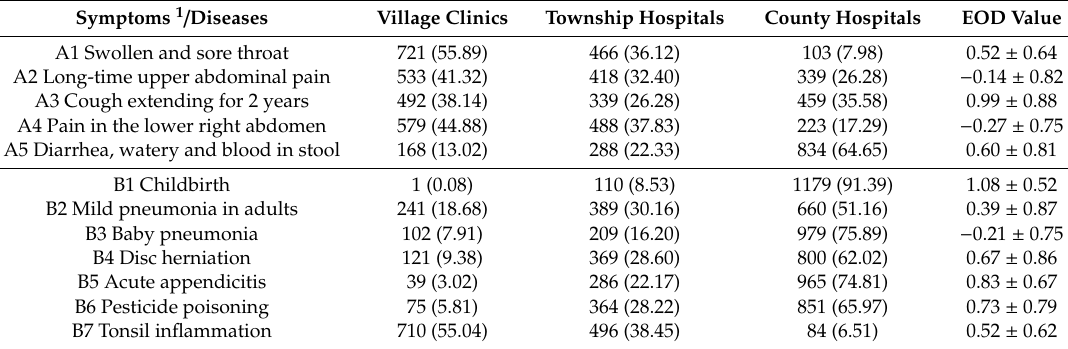
Table 3. Residents’ medical willingness for each symptom or disease ( n ,%; n = 1290).